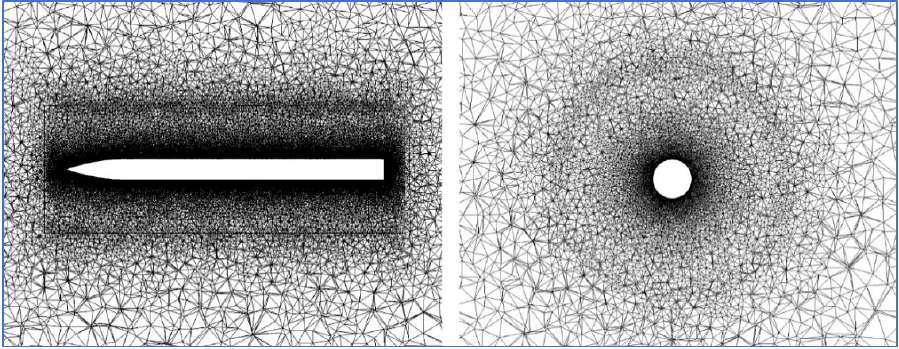
Figure 1. Left : Detail of the nearfield at plane x-z. Right : Detail of the nearfield at plane y-z constant. A study with several values o f time steps (Δ t ), ranging from 0.005 s t  = to 0.0001s t 